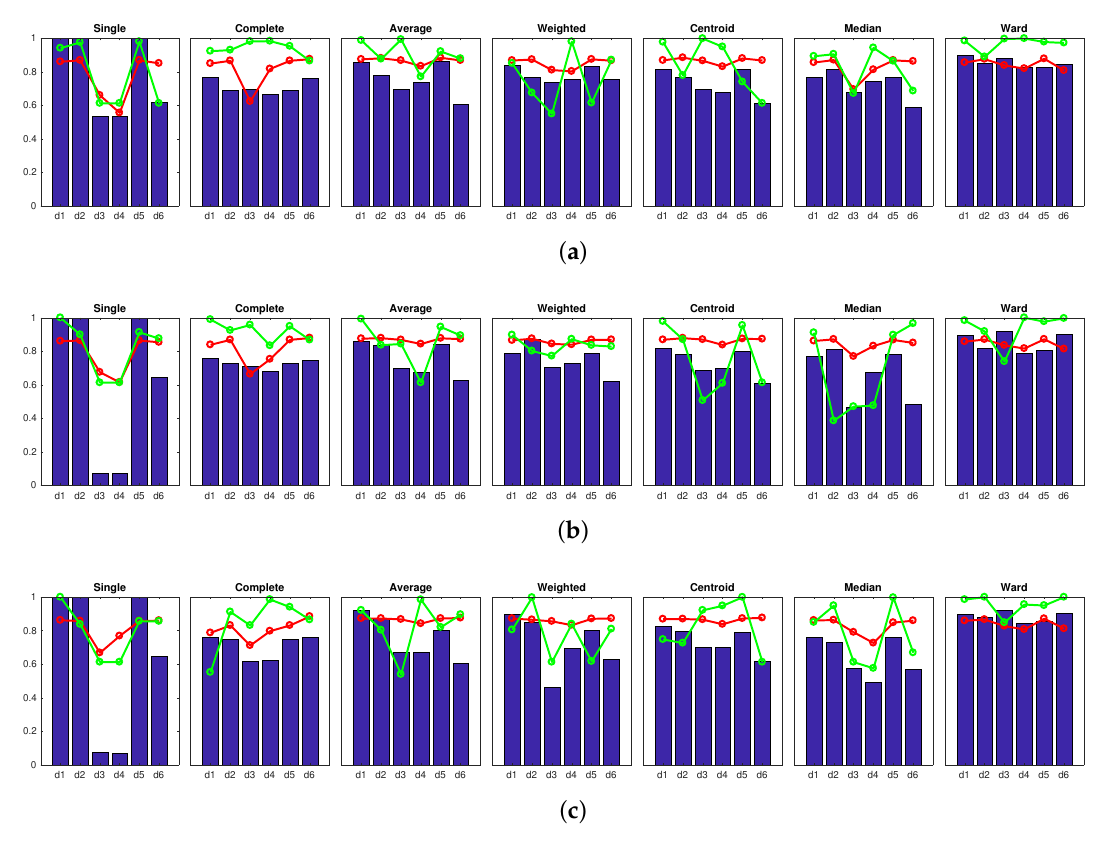
Figure 19. Legend: (cid:4) Accuracy c ; −◦− Correlation γ coph ; −◦− Inconsistency δ inconsist . Results of the high-level clustering with the complete dataset. Gist descriptor ( a ) m = 16, k 6 = 8; ( b ) m = 16, k 6 = 16; ( c ) m = 16, k 6 = 32.